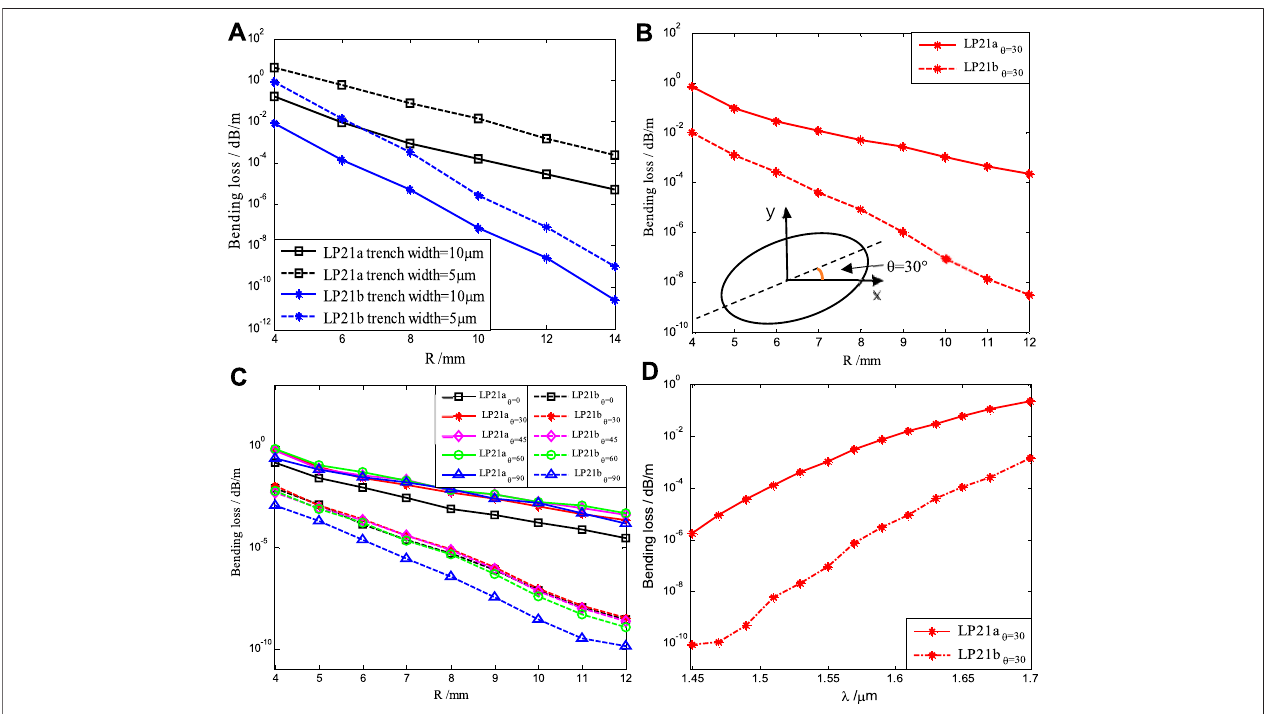
FIGURE 8 | When the light wavelength is 1.55 μ m, effect of different trench widths on bending loss (A) , bending losses of the modes LP21a and LP21b for θ (cid:1) 30 ° (B) ,bendinglossesofthemodesLP21aandLP21bfor θ (cid:1) 0 ° ,30 ° ,45 ° ,60 ° ,90 ° (C) .Variationsofbendinglosseswiththeinputwavelengthfor θ (cid:1) 30 ° andR (cid:1) 10 mm (D) .